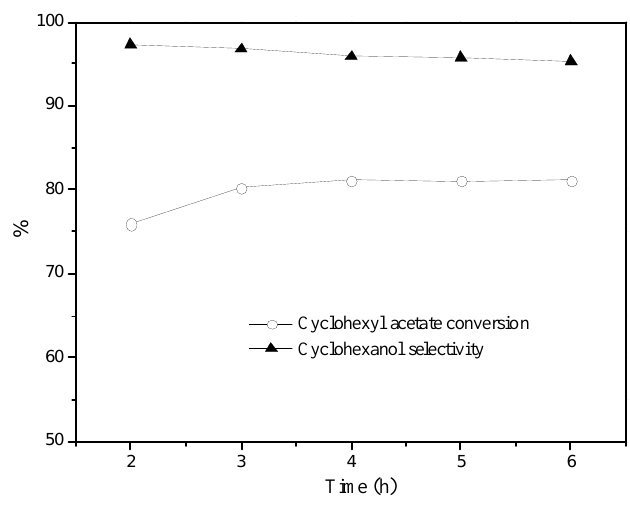
Figure 7. Effect of reaction time on the hydrolysis of cyclohexyl acetate over CSALA. Reaction conditions: cyclohexyl acetate 8 mL (55 mmol), H 2 O 24 mL (1333 mmol), CSALA 1.2 g, 130 °C.